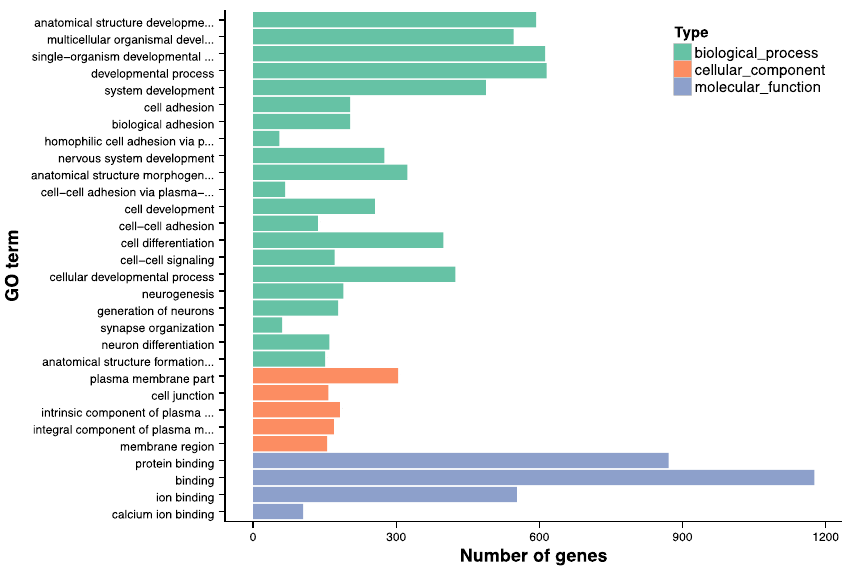
Figure 3. GO term analysis for genes annotated to DMRs. The bar graph shows the GO terms categorized by biological process, cellular component and molecular function. The GO terms represent gene functions that are related to groups of genes which were annotated to DMRs in our study.